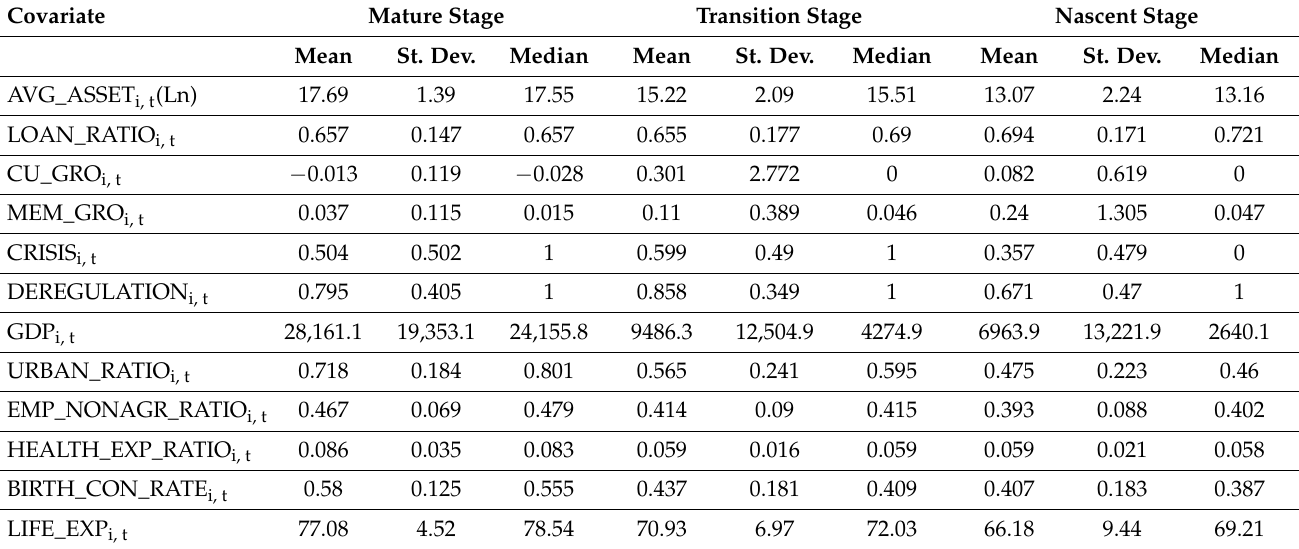
Table 5. The mean of time-varying covariates among mature/transition/nascent-stage